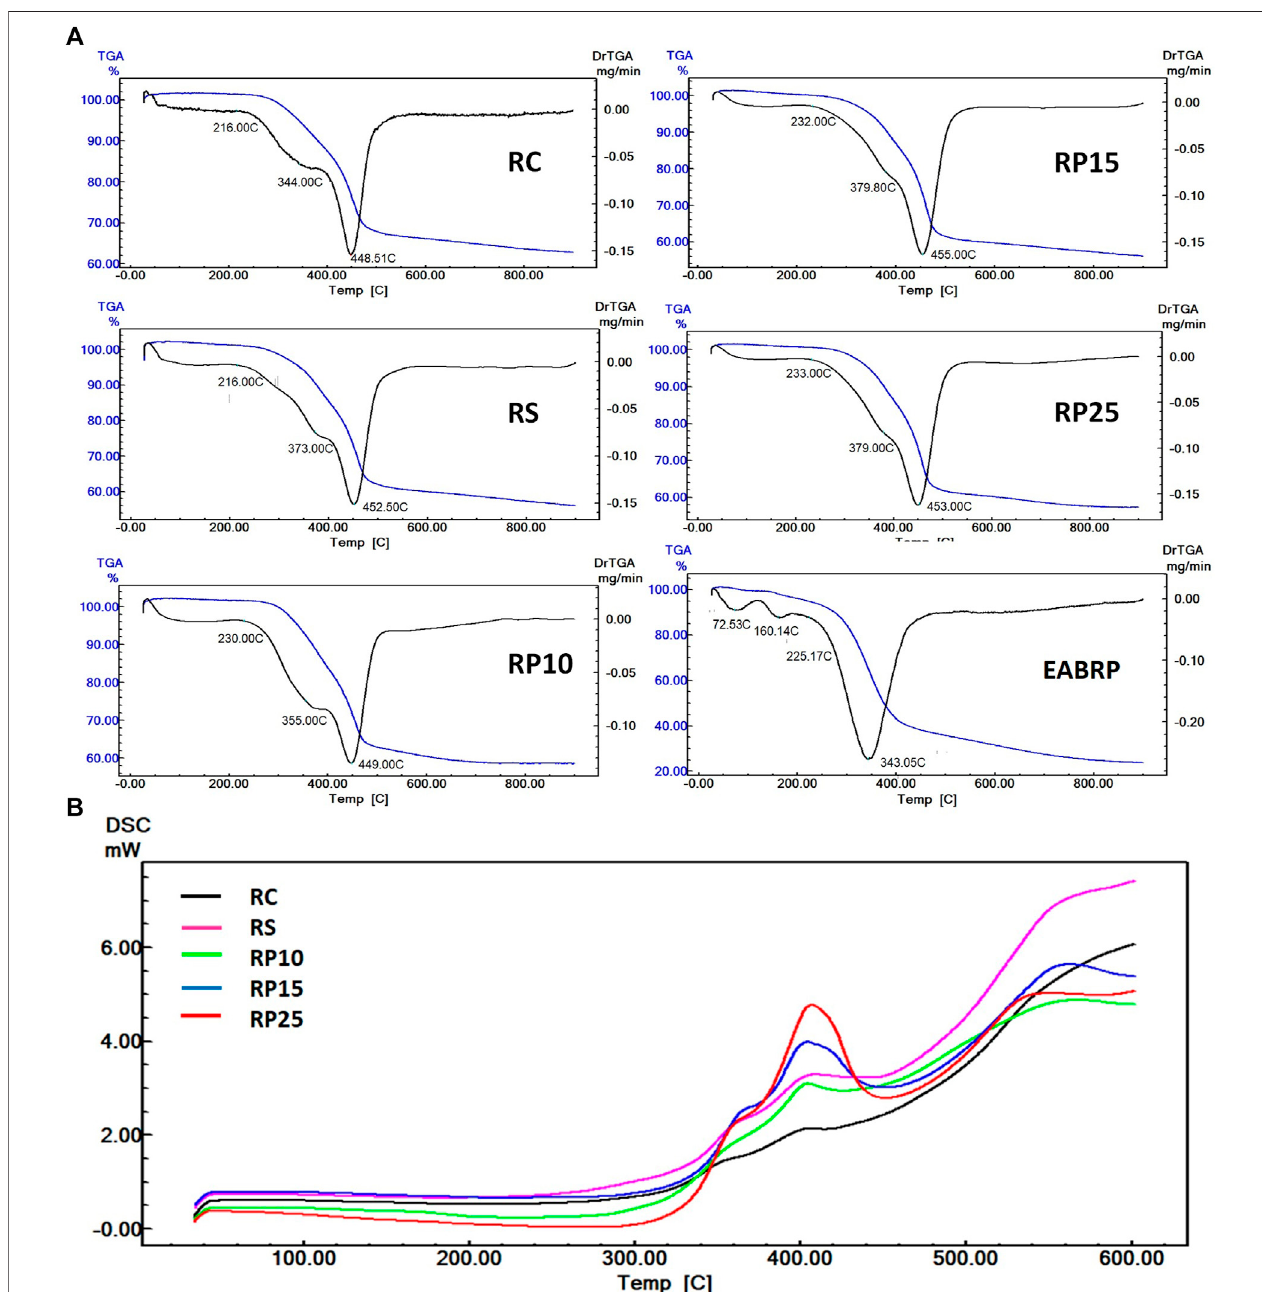
FIGURE 8 | Overlapping thermograms of experimental and control resins. (A) : Overlapping TGA and DTG thermograms. (B) : Overlapping DSC thermograms.